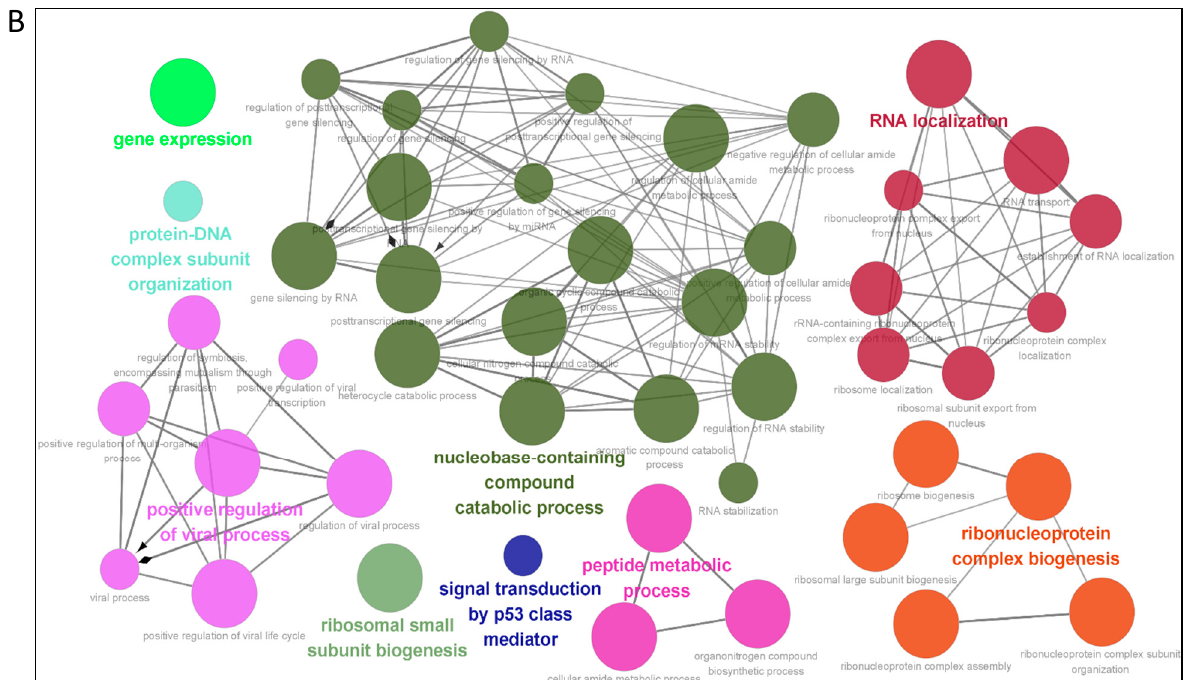
Figure 3. Gene ontology analysis of the identified PCV3 and PCV4 Cap-host interactome. ( A , B ) Rep- resentative overrepresented GO terms of protein clusters and the GO distribution of all proteins in PCV3 and PCV4 Cap-transfected cells versus empty vector-transfected cells were classified into three categories using the GOclue plugin in Cytoscape software, version 3.7.1. Shown are the significantly enriched terms based on biological process (BP), molecular function (MF), and cellular component (CC) with p -values < 0.05. The Roman numerals represent the detailed GO terms, as shown in Supplementary Table S4.